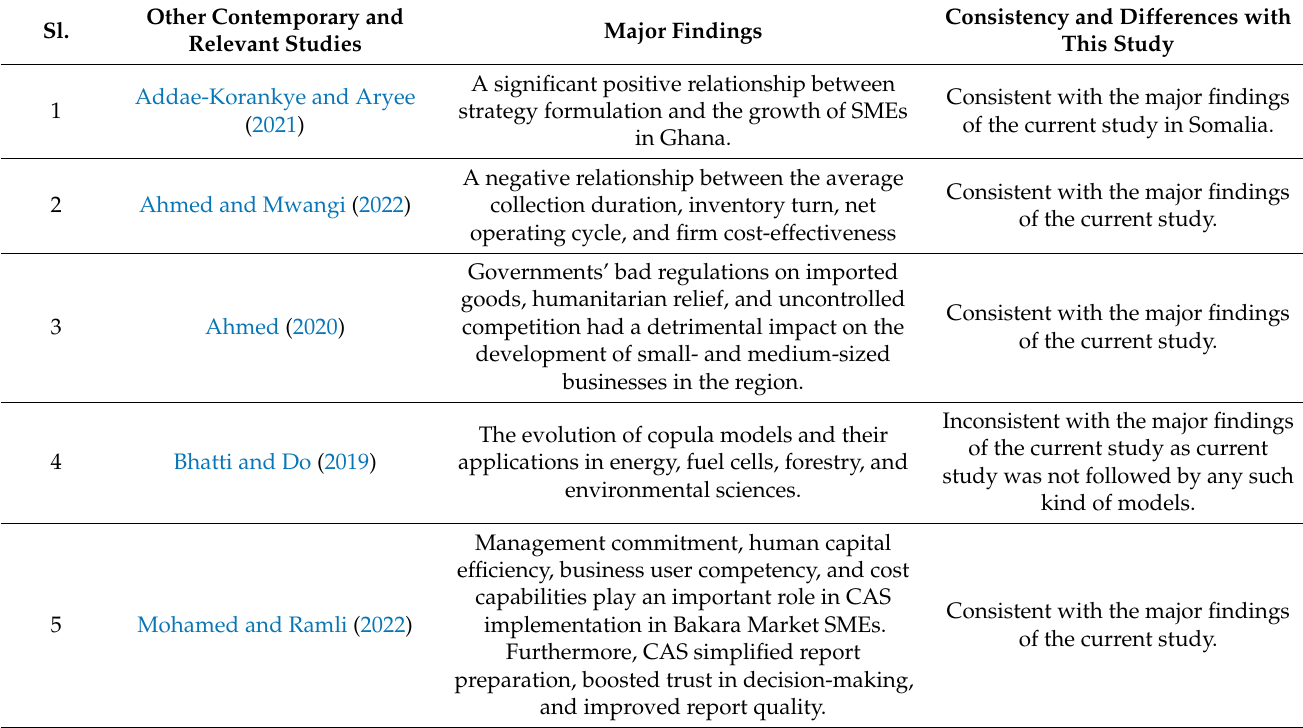
Table 22. Consistency and Differences of Major Findings with other